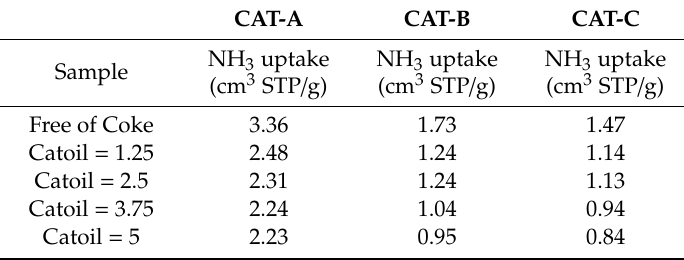
Table 2. NH 3 -TPD for CAT-A, CAT-B, and CAT-C catalyst